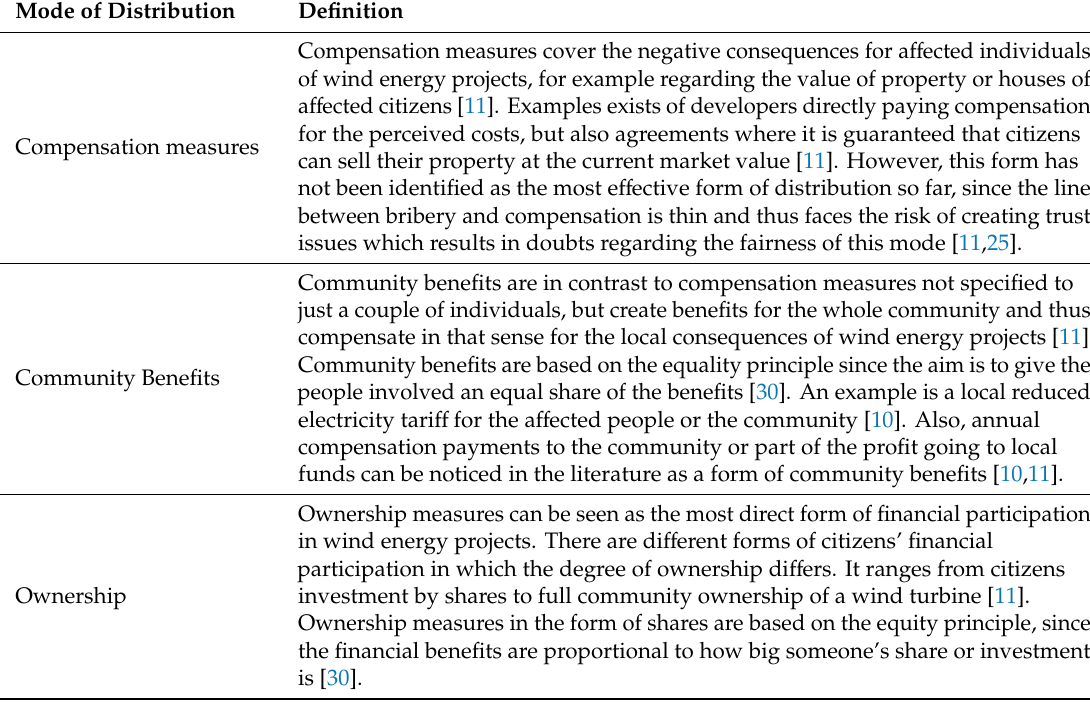
Table 2. Forms of distribution of benefits identified by the literature